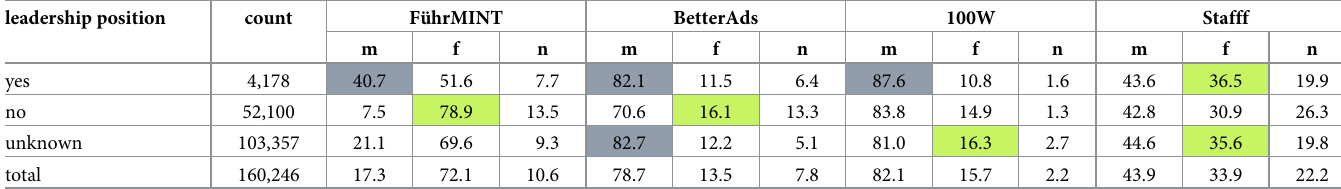
Table 9. Percentage of job ads classified as having a male connotation (m), a female connotation (f), or a neutral connotation (n), broken down by leadership. The color-highlighted cells correspond to the groups of job ads (leadership: yes/no/unknown) with the statistically significant highest proportions per tool and gender category (green for female-connoted and grey for